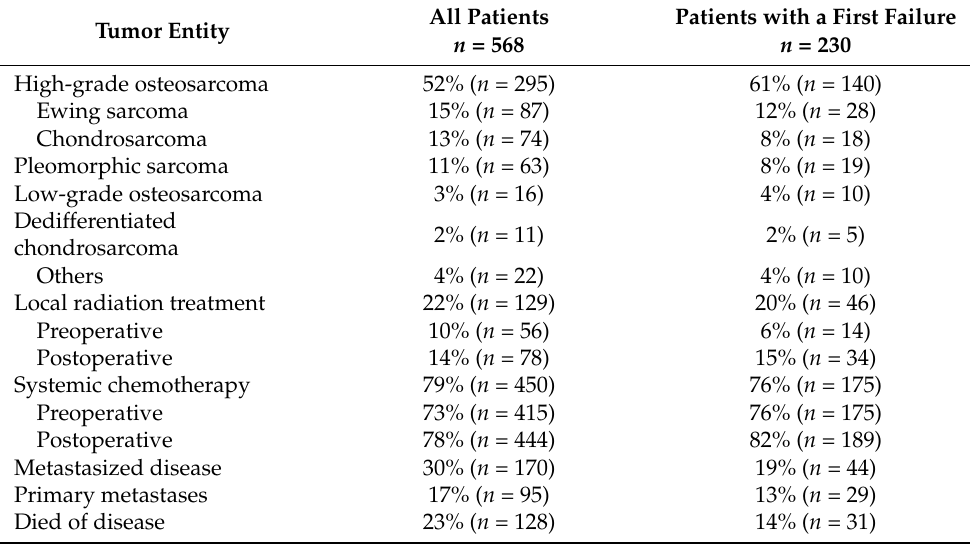
Table 2. Oncological details for all patients excluding local tumor progression as a first failure mode, patients with a first failure excluding patients who underwent amputation for the first failure and patients with a second